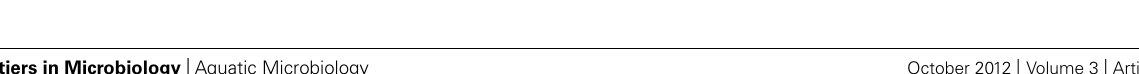
FIGURE 2 | Environmental influences of nitrate (A), sulfide (B), and DOC (C) on denitrification and nitrogen species end